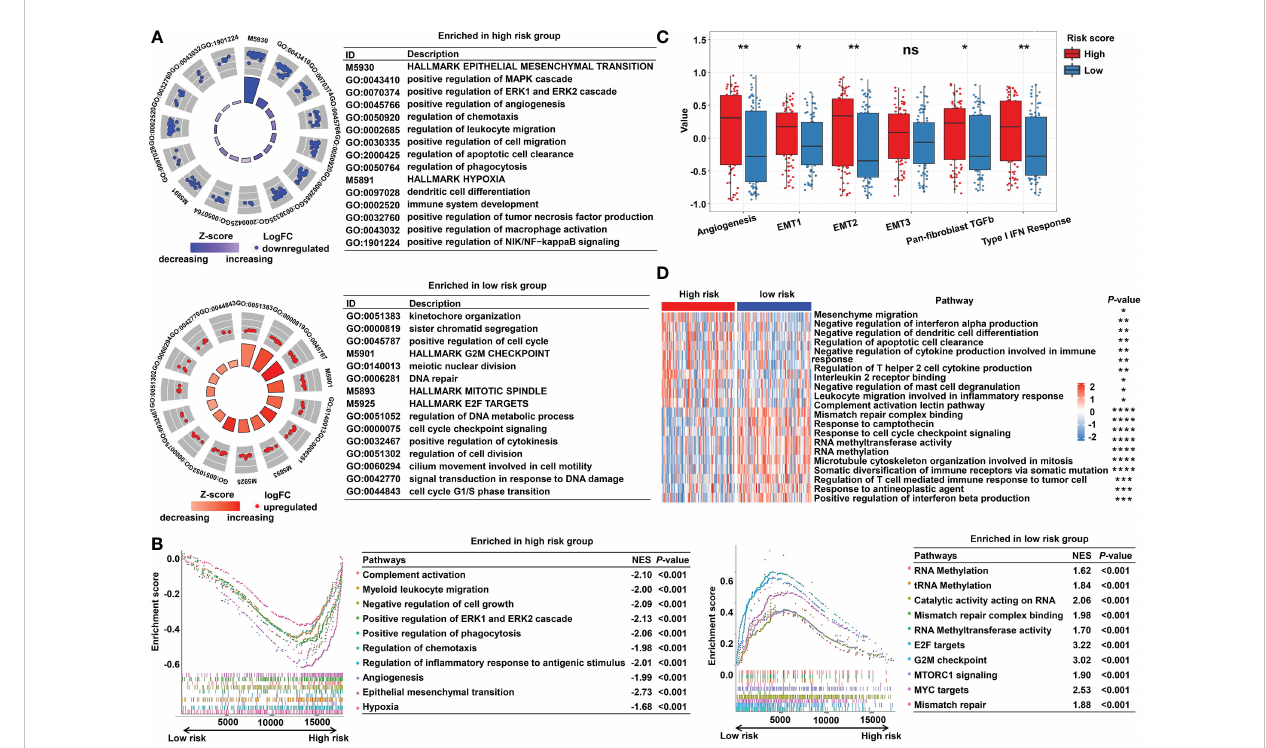
FIGURE 5 Functional enrichment analysis of the m 5 C methylation-based signature between low- and high-risk READ patients. (A) The enriched pathways including GO and HALLMARK terms are displayed by GOcircle plots. The red and blue dots represent the genes upregulated in the low-risk and high-risk categories separately. (B) GSEA enrichment plots for the two subgroups in the TCGA cohort. (C) The GSVA analysis for hallmarks of cancer in the TCGA cohort. (D) The heat map drawn for GSVA analysis based on GO terms. DEGs, differentially expressed genes. **** P < 0.0001; *** P < 0.001; ** P < 0.01; * P < 0.05; ns, not signi fi